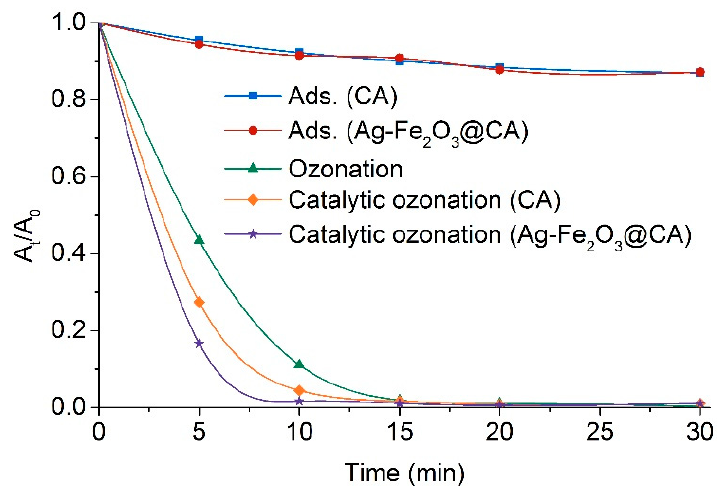
Figure 9. Color of Effluent 1 treated by various processes.